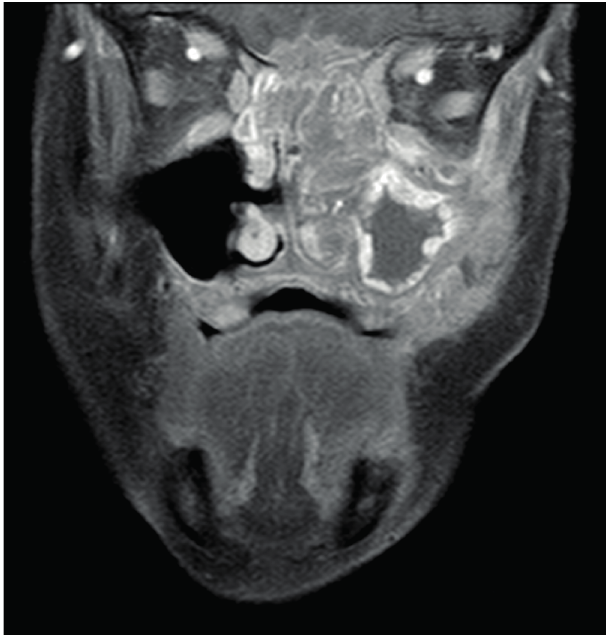
Figure 3. Coronal section of MRI scan somewhat posterior to Figure